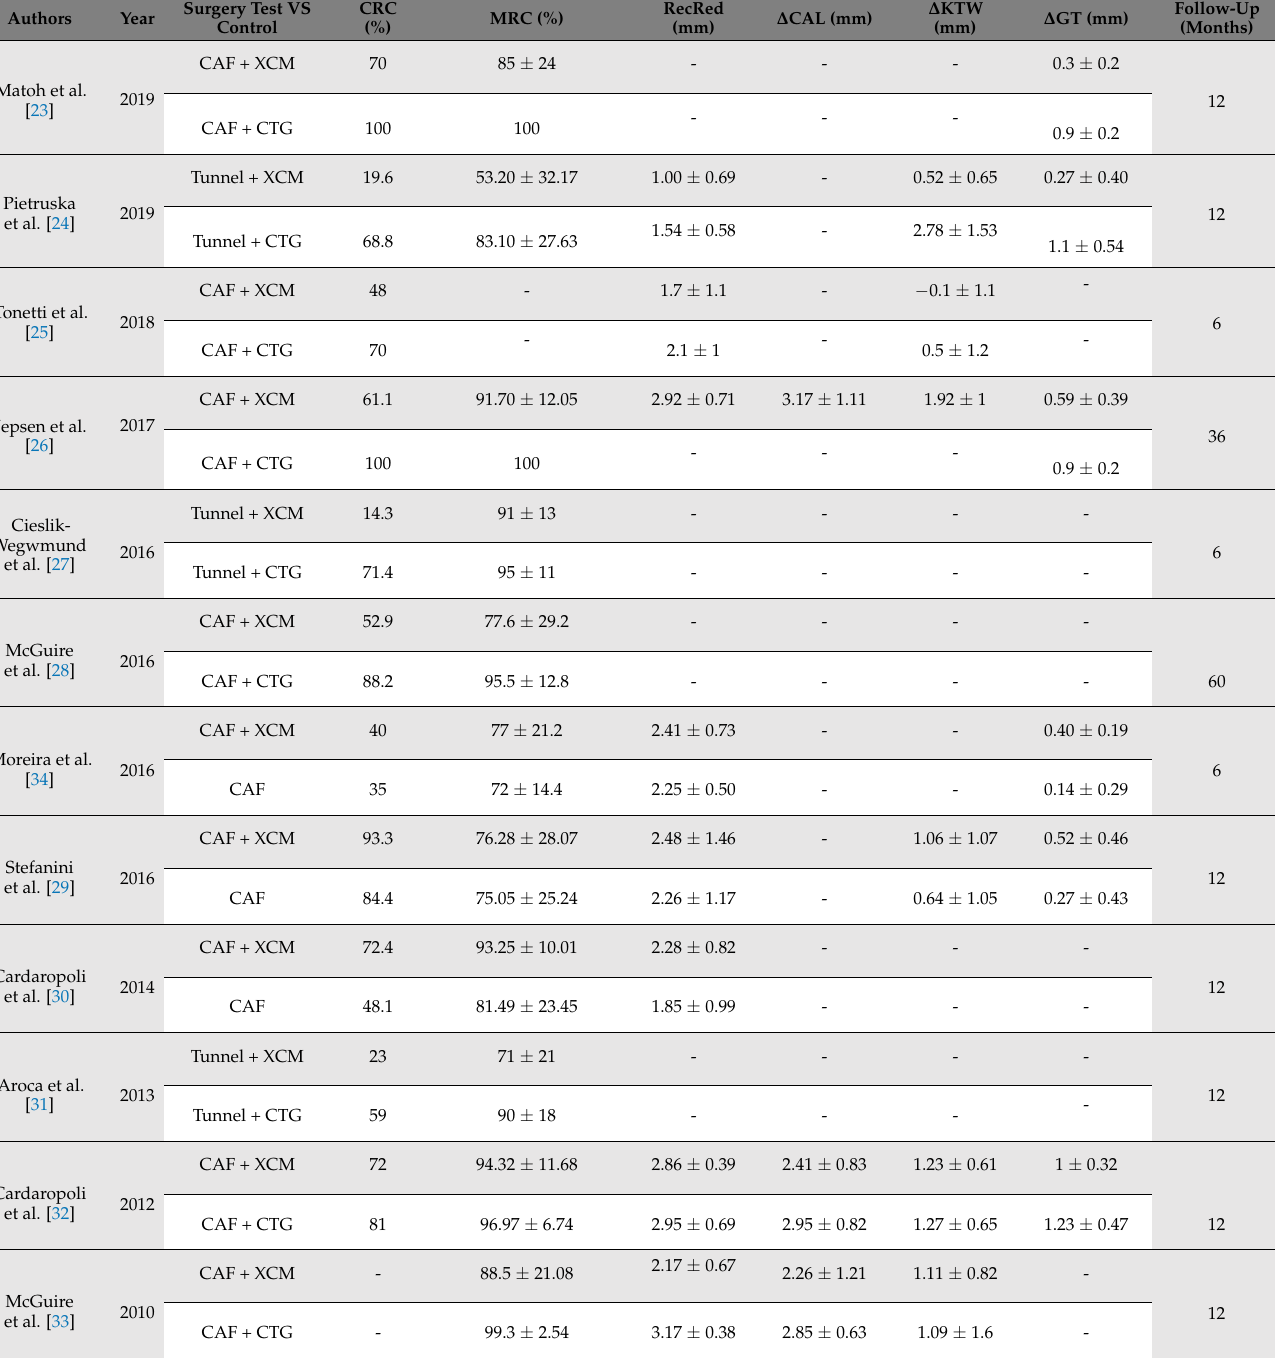
Table 2. Parameters used in the articles and their